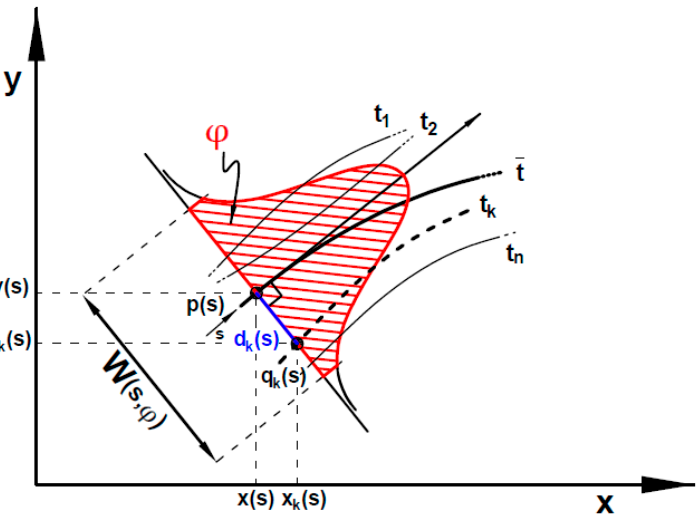
Figure 2. Observed trajectories ( t 1 ,t 2 ,…, t n ) of an agent and related average trajectory (cid:1872)̅ .